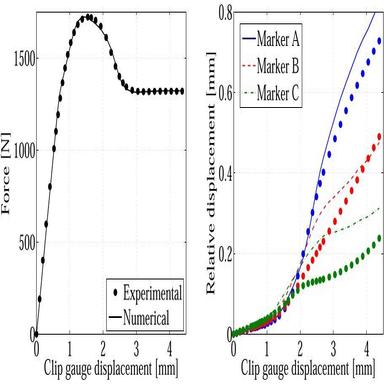
Mechanical response using MISO5 model for the best fitting of force f F .